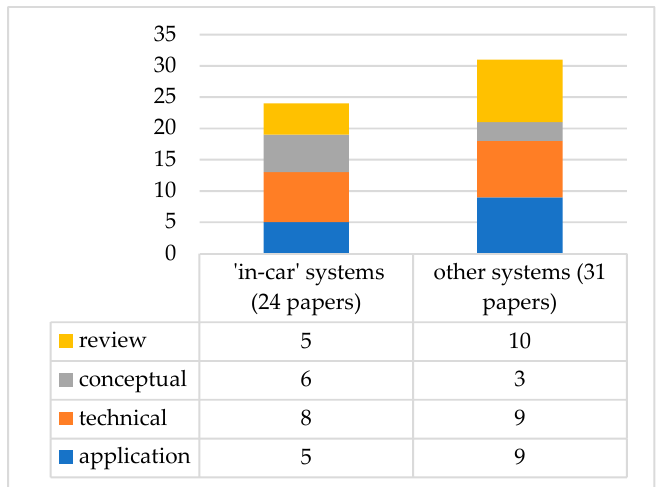
Figure 4. Distribution of papers according to their type.